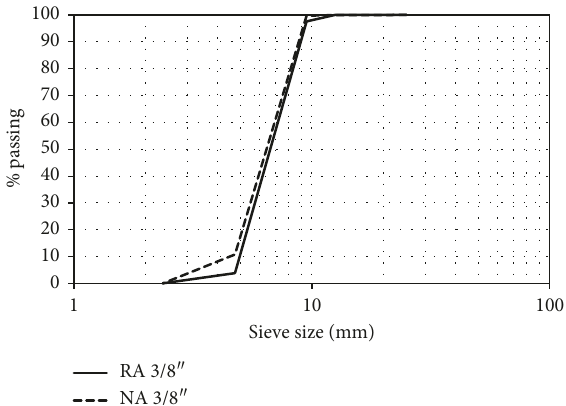
coarse aggregates. ″